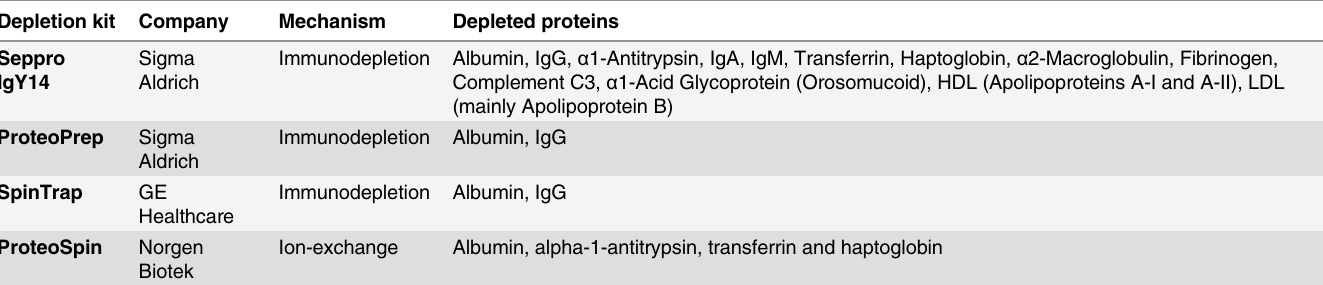
Table 1. Characteristics of the applied depletion